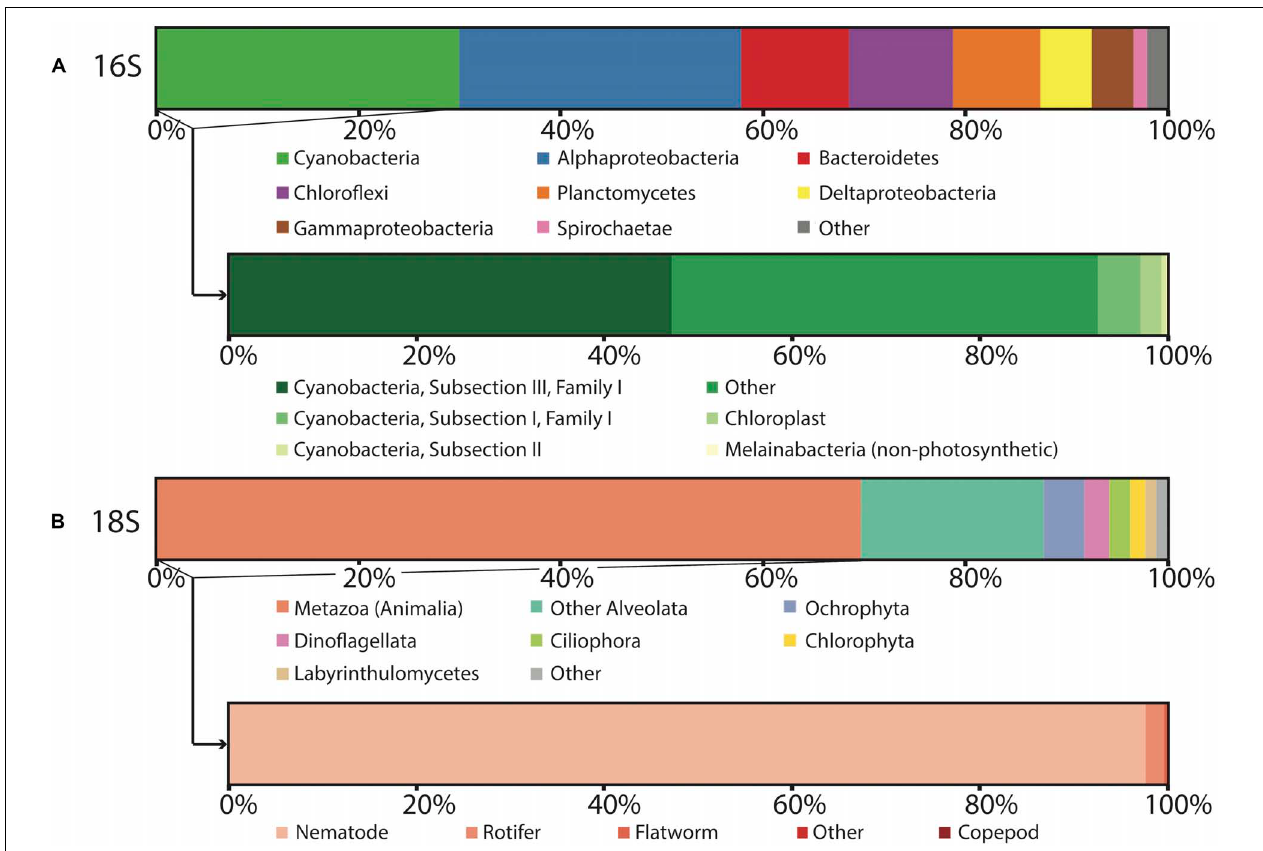
FIGURE 4 | Microbial diversity of polygonal mat CC2 recovered using iTag sequencing of the (A) 16S rRNA gene, with inset showing cyanobacterial diversity, and (B) 18S rRNS gene, with inset showing metazoan diversity. Relative abundances (%) do not include reads unassigned to any taxon, which comprise 22% of the total 16S reads and 17% of the total 18S reads. Operational taxonomic units assigned to families constituting a small percentage of total reads are labeled